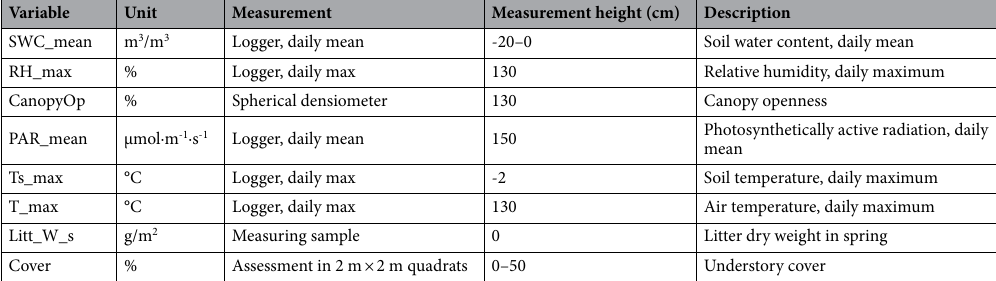
Table 2. Environmental variables used in constrained ordination analysis to explain species responses to environmental gradients, including microclimate and vegetation related parameters, measured at different strata in the experimental plots.